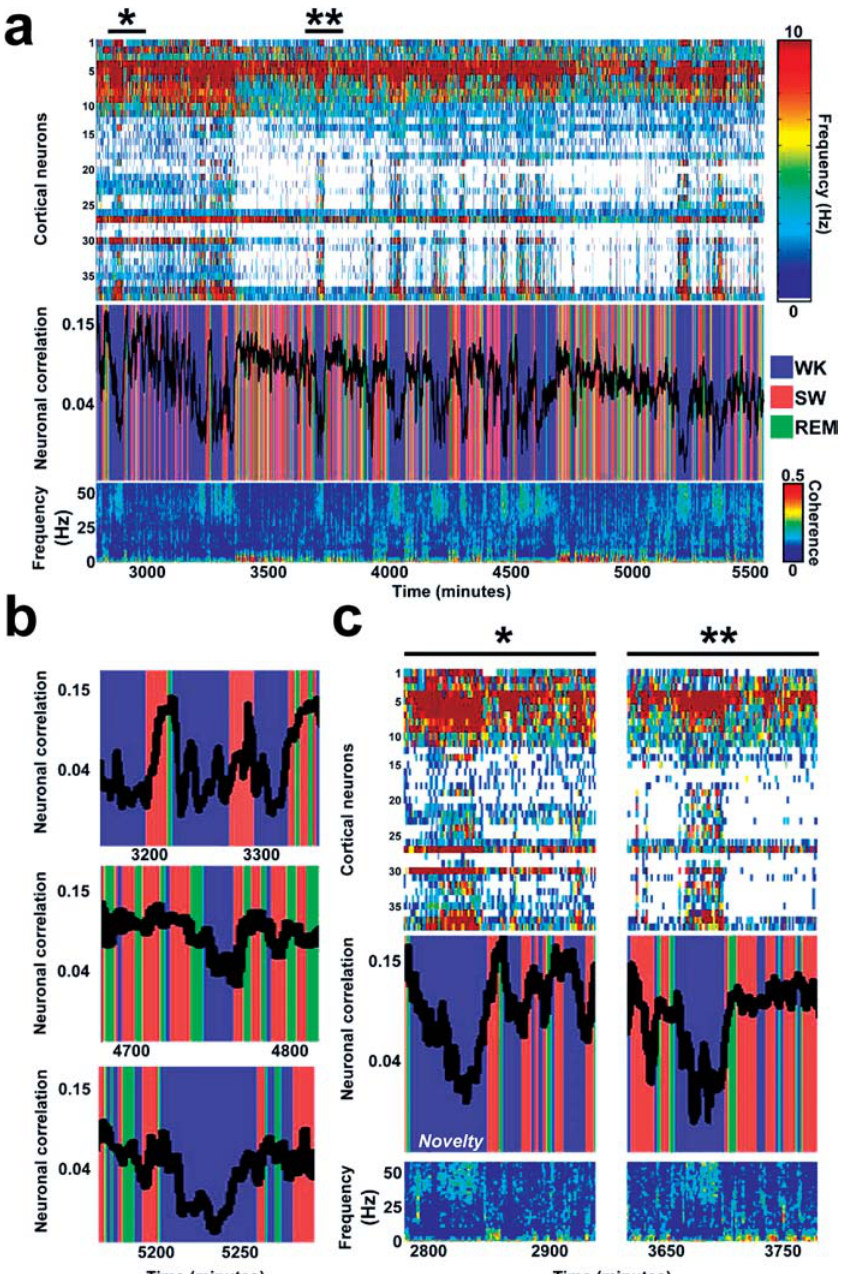
Figure 5. Neuronal Reverberation Is Stron- gest during SW Sleep (A) Rat 5 (CX) dramatically illustrates the state dependency of neuronal ensemble correlations, which are strongly in- creased by SW sleep but readily de- creased by WK. The upper panel shows the firing rates of 38 cortical neurons for approximately 45 h after exposure to novel stimulation (indicated by an aster- isk). The middle panel shows the super- imposition of successive neuronal ensemble correlations and concurrent behavioral states. Nearly all correlation peaks correspond to SW episodes, while almost all troughs match WK epochs. The lower panel represents pooled LFP forebrain coherence (Amjad et al. 1997) over time, useful to discriminate be- tween WK (strong coherence above 25 Hz and weak coherence under 5 Hz) and SW sleep (the opposite). Notice that in this particular example (rat 5, CX), REM episodes show correlations similar to those of SW sleep, but, as shown in Figure 4, this was the exception and not the rule across several animals. (B) State-dependent neuronal reverber- ation was sustained throughout the recording period, as shown by segments representing the beginning (3,200–3,300 min), middle (4,700–4,800 min), and end (5,200–5,250 min) of the experimental record. In the upper panel, notice the progressive increase of neuronal corre- lations across single SW sleep episodes. (C) Blow-up of two selected data seg- ments indicated by asterisks in (A). Despite having being sampled from mo- ments of high neuronal firing rates (asterisk), novel stimulation templates reverberate most strongly during SW sleep when firing rates are low (single asterisk and double asterisks). The high firing rates that characterize WK corre- spond to decreased neuronal reverber- ation, probably due to sensory